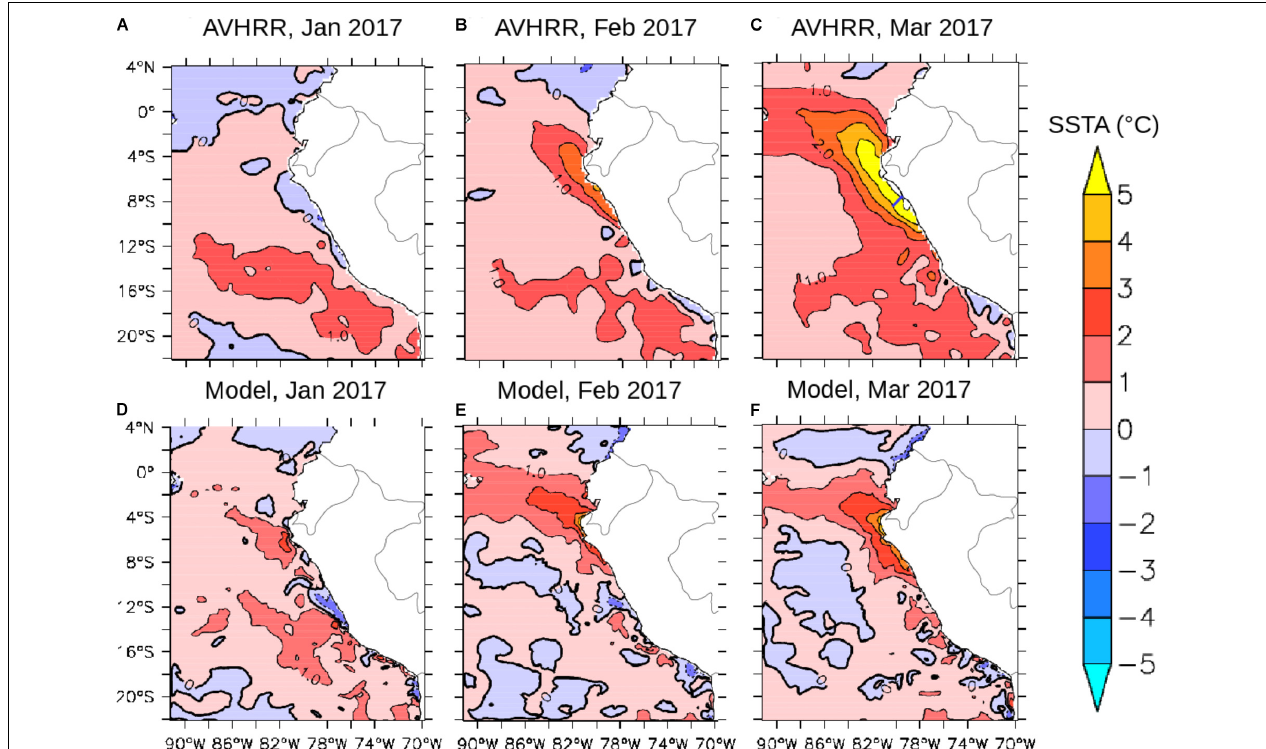
FIGURE 4 | SST anomalies in (A,D) January, (B,E) February, and (C,F) March 2017 from SST observations (top) and model output (bottom). Anomalies were computed with respect to 2013–2016 climatology. The blue line in (C) indicates the location of the Chicama